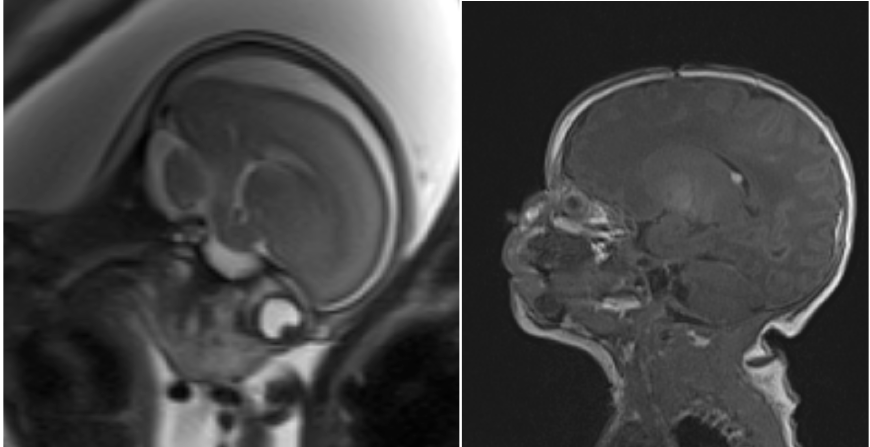
Figure 2. Left: fetal T2-weighed MRI at 24 gestational weeks. Right: postnatal T1-weighed MRI. Both show a subependymal nodule in the posterior right lateral ventricle.